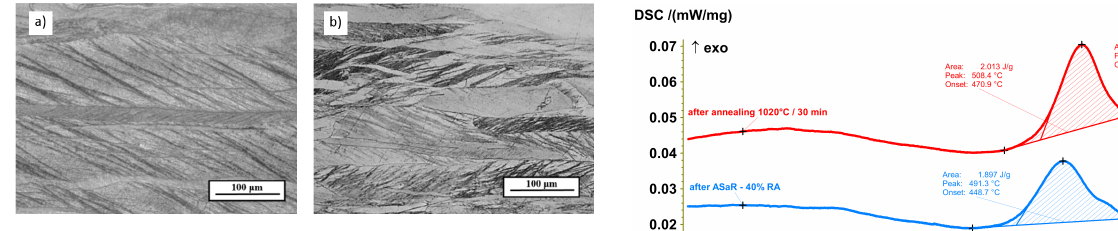
Figure 2: Optical micrographs of Cu after: a) ASaR – 70% RA; b) AScR – 60% RA.